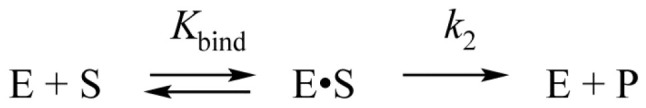
The kinetic mechanism of the interaction of APE1 with a damaged quadruplex. E, enzyme; S, substrate; ES, enzyme-substrate complex; P, product.